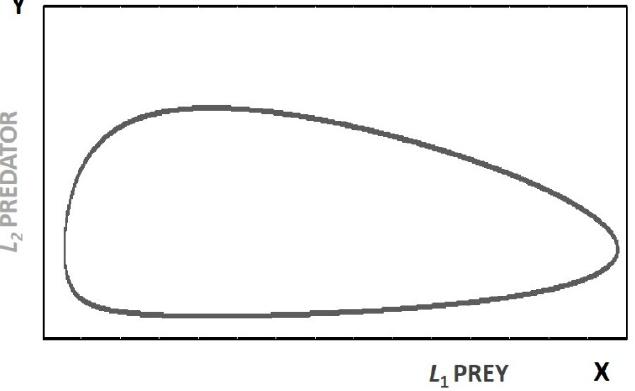
Figure 3. Prey–predator periodic behaviors represented in the space of the two